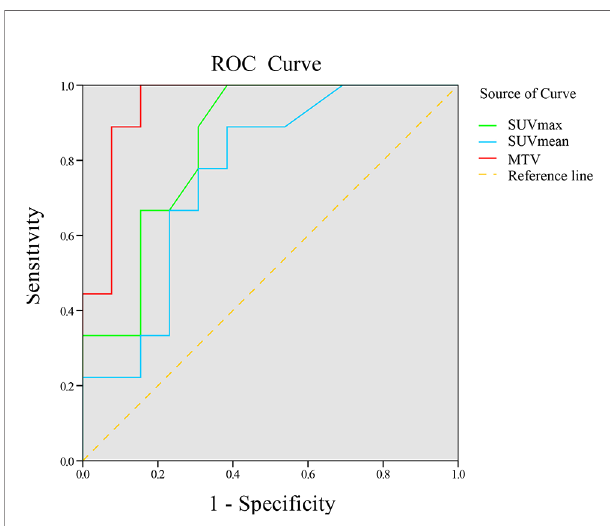
FIGURE 3 | ROC curve of 18 F-RGD PET/CT parameters to predict tumor response to combined anti-angiogenesis with chemotherapy.